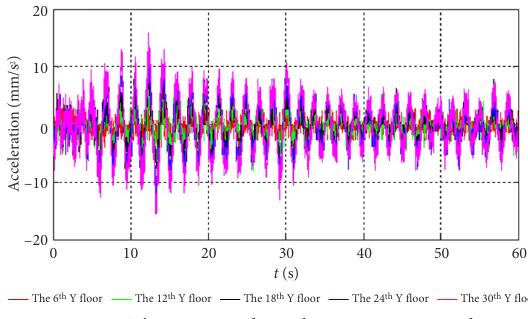
Figure 9. The measured acceleration response data of five storeys along Y-axis